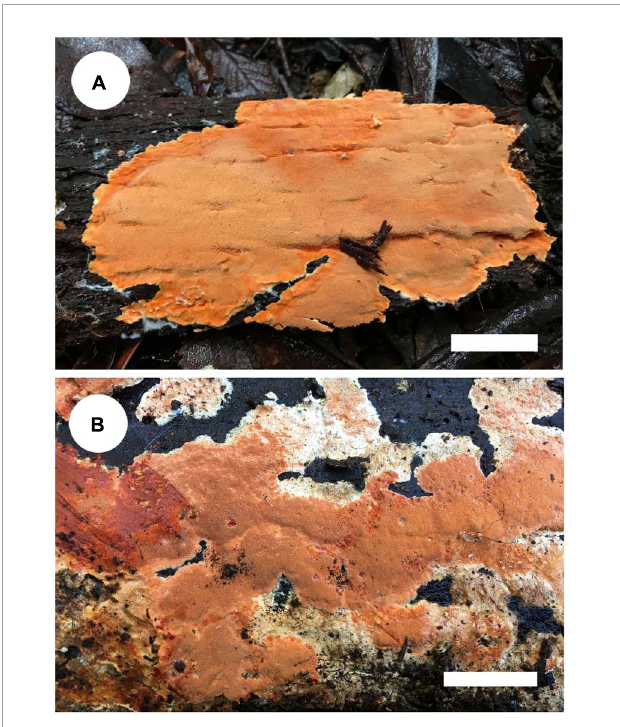
FIGURE5 Basidiomata of Gloeoporellus species: G. merulinus ( A : Cui 16724; B : Dai 18735). Scale bars: A , B = 2 cm.